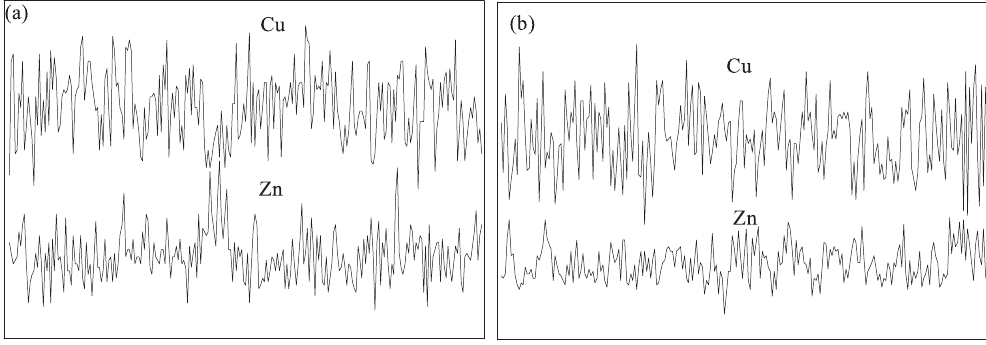
Fig. 4: Distribution of Zn, Cu in the CuZn alloy. (a) Original; (b) after 3 GPa